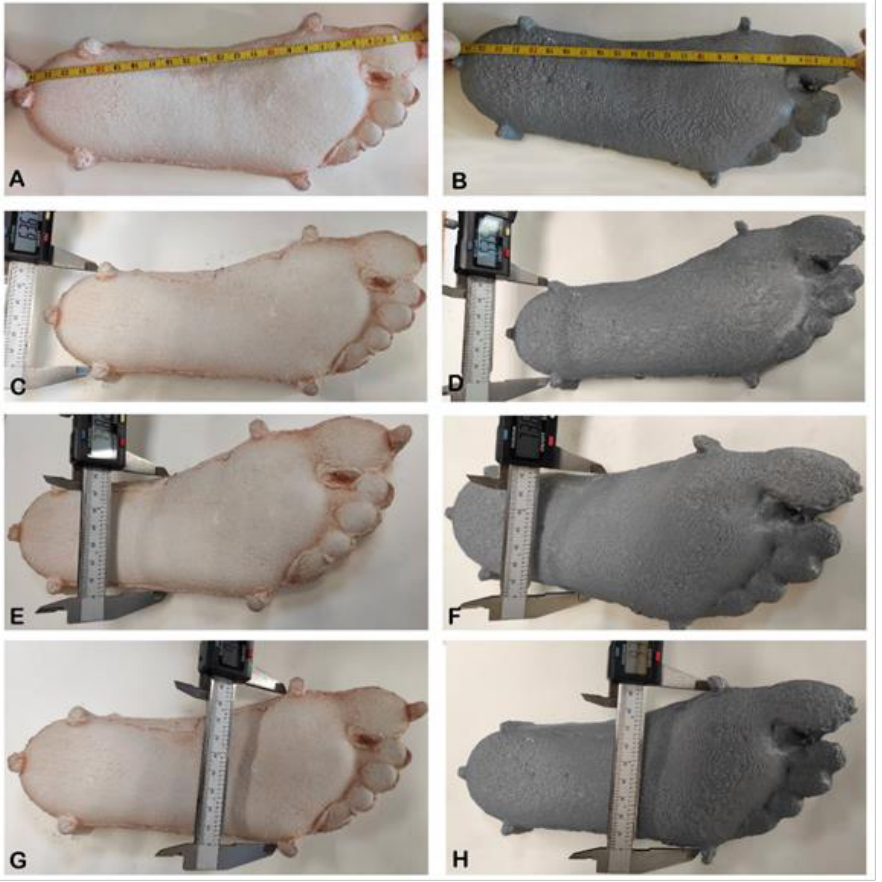
Figure 2. Method for verifying dimensions of the positive casts with a tape measure and Powerfix caliper. Measurement of length ( A and B ), rearfoot ( C and D ), midfoot ( E and F ) and forefoot ( G and H ) of the positive casts made of plaster and plastic, respectively.